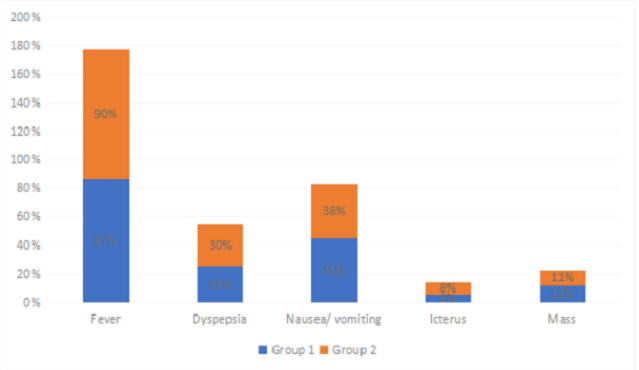
Figure 1. Graphical comparison of clinical features in groups